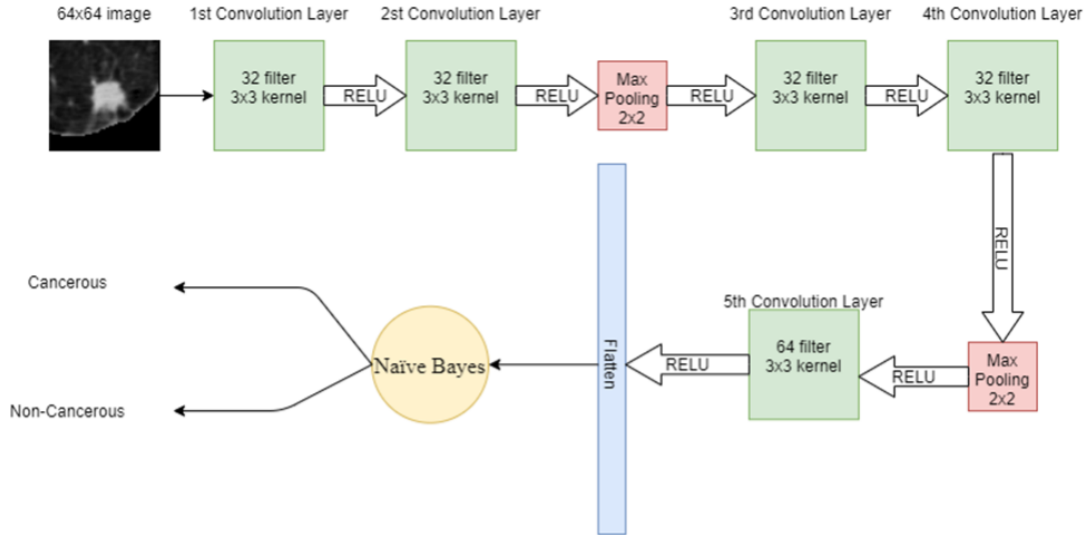
Figure 7. Proposed hybrid model using CNN with